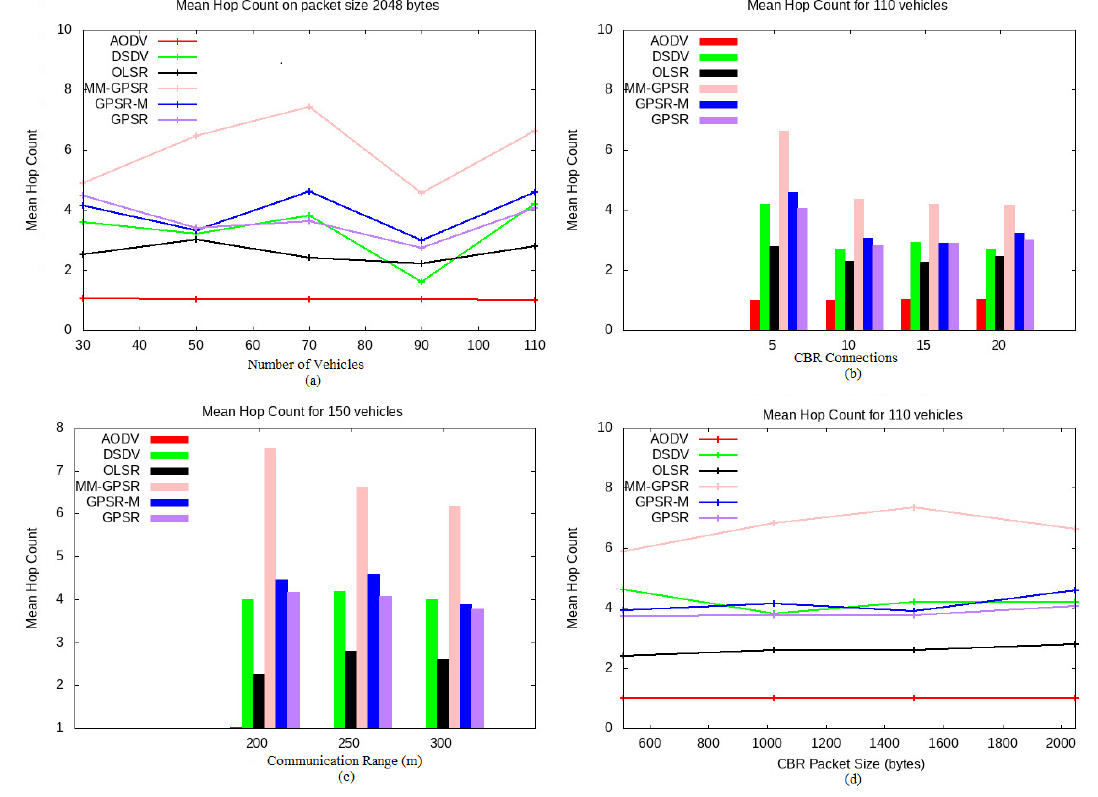
Figure 6. MHC results on various network